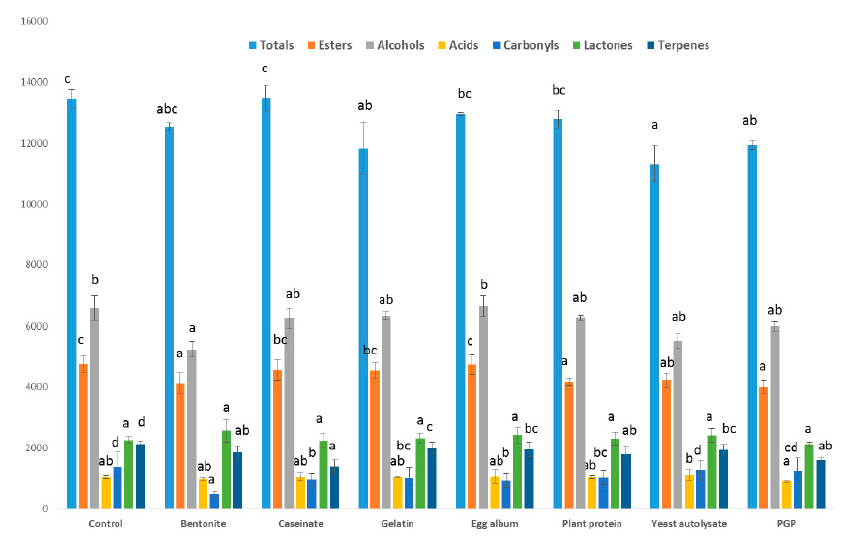
Figure 1. Effect of the fining agents and the purified grape pomace on the different families of Figure 1. E ff ect of the fining agents and the purified grape pomace on the di ff erent families of aromatic aromatic compounds in wine (expressed as μ g/L). compounds in wine (expressed as µ g /